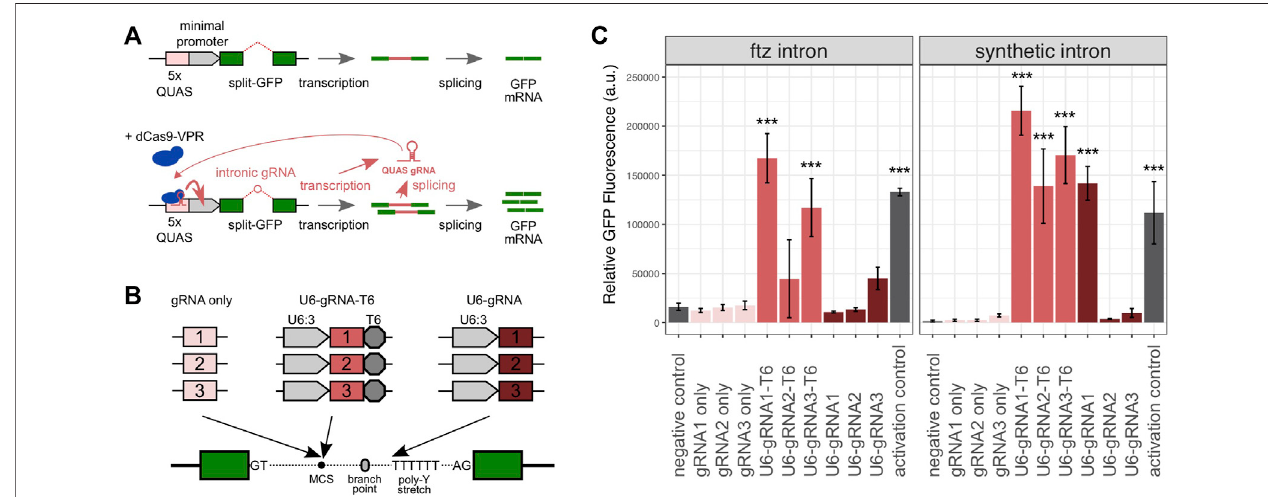
FIGURE 1 | Characterization of intron-encoded gRNAs in Drosophila S2 cells. (A) Assay consists of a GFP reporter split by the presence of an intron and the dCas9-VPR activator component. In the absence of a gRNA guiding the activator, the reporter exhibits low levels of eGFP fl uorescence. Following the activation by the dCas9:gRNA complex at the 5 ′ QUAS motif, eGFP fl uorescence is ampli fi ed. This requires both successful splicing and the gRNA expression from within the intron. Relative fl uorescence is subsequently measured by fl ow cytometry, allowing each gRNA con fi guration to be compared to a negative control (no gRNA) and a positivecontrol(gRNAprovidedseparately). (B) ThreeintronicgRNAdesignsweretestedwithorwithoutaU6promoter,eachwiththreepreviouslycharacterizedQUAS- targeting gRNA spacers, cloned at the multiple cloning site (MCS) near the intronic branch point, or directly adjacent to the polypyrimidine stretch toward the 3 ′ end of each intron. (C) Relative mean eGFP fl uorescence and SD from triplicate transfections of each intronic gRNA variant, using either the ftz or minimal introns. The p values were calculated using one-way ANOVA and Tukey multiple comparisons of means (* p < 0.05; ** p < 0.01; and *** p <